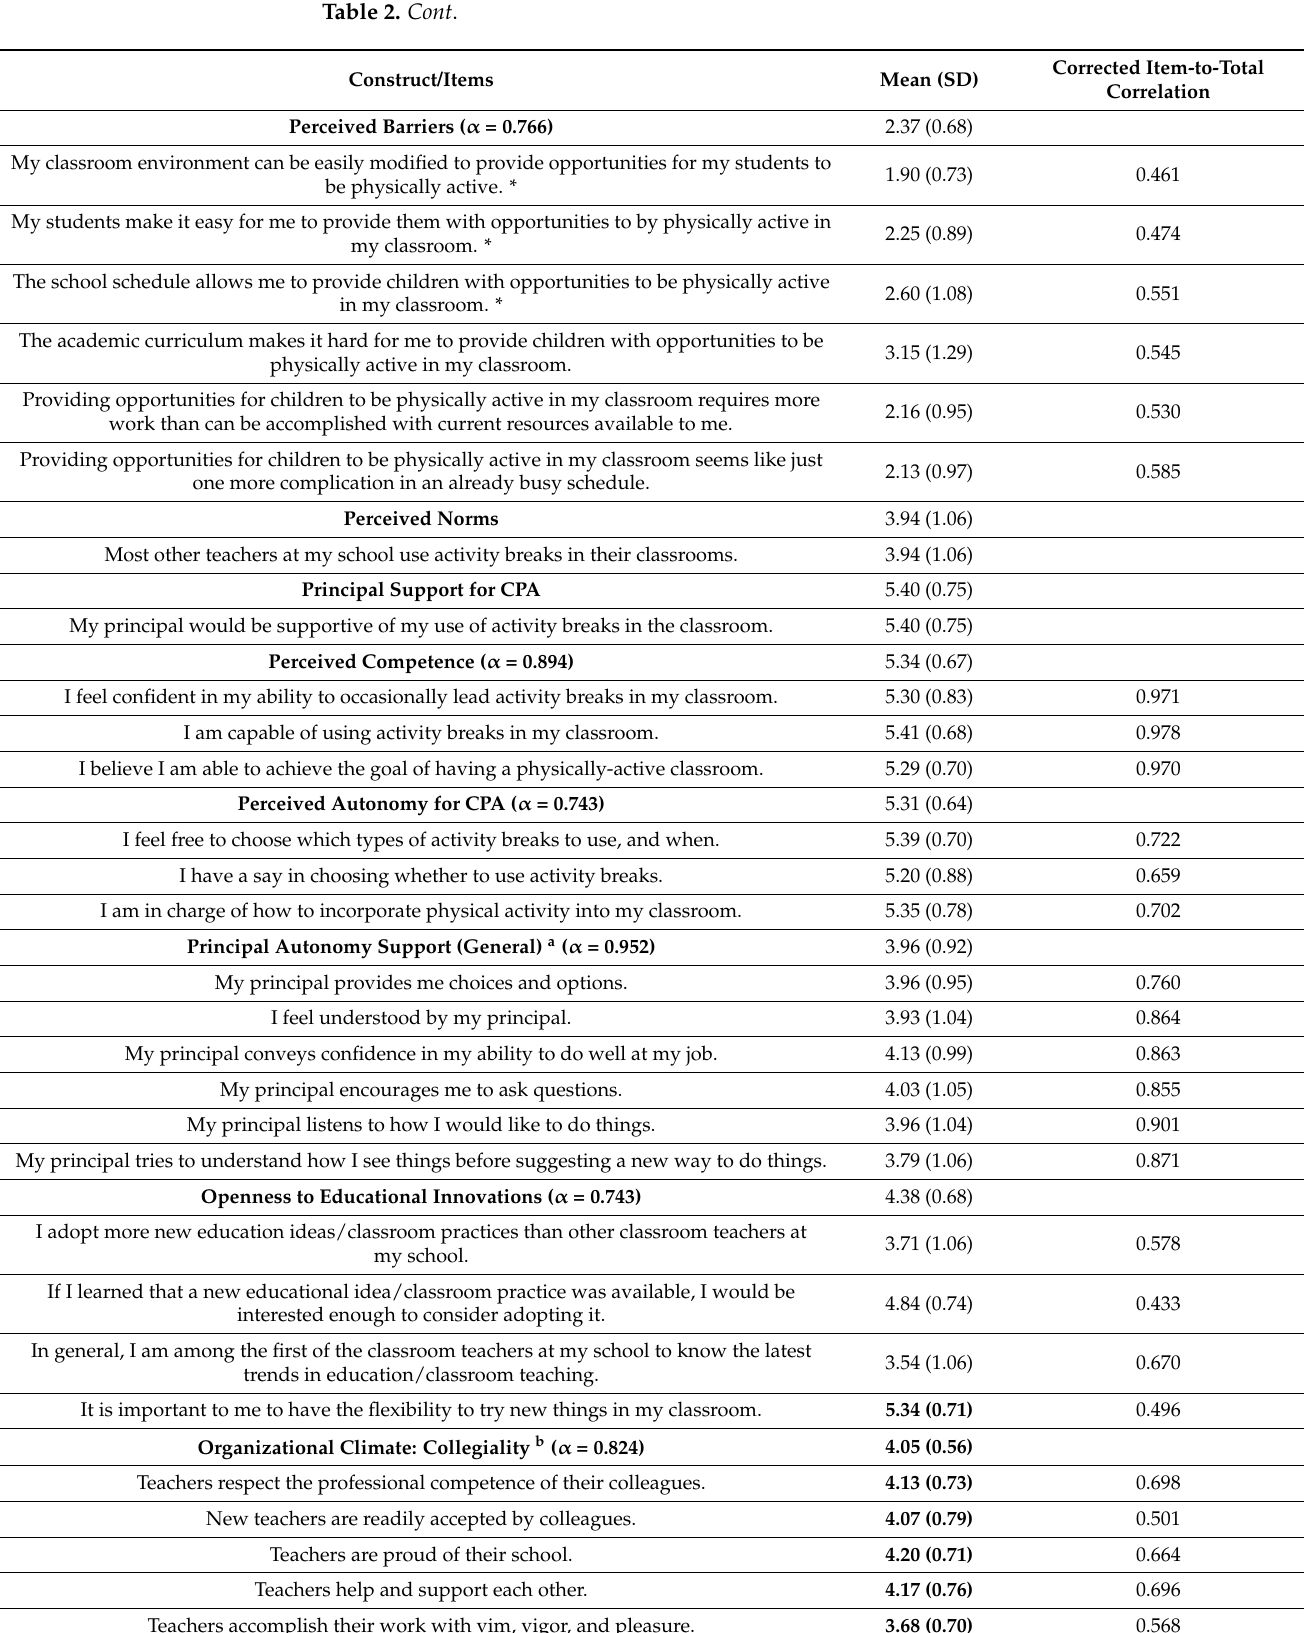
Table 2. Cont . Construct/Items